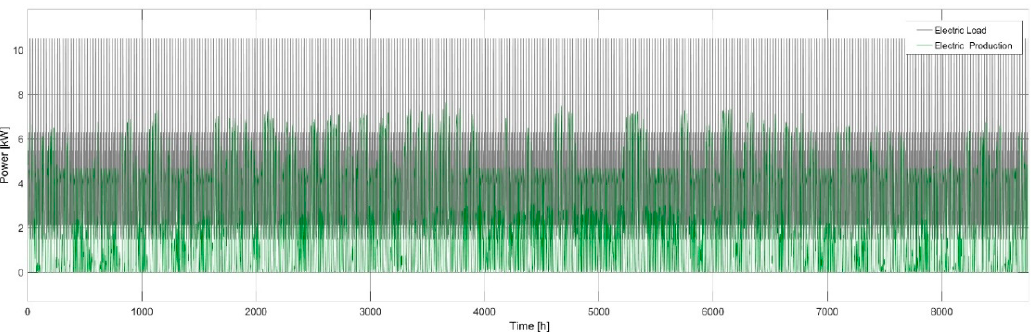
and in green the energy produced).